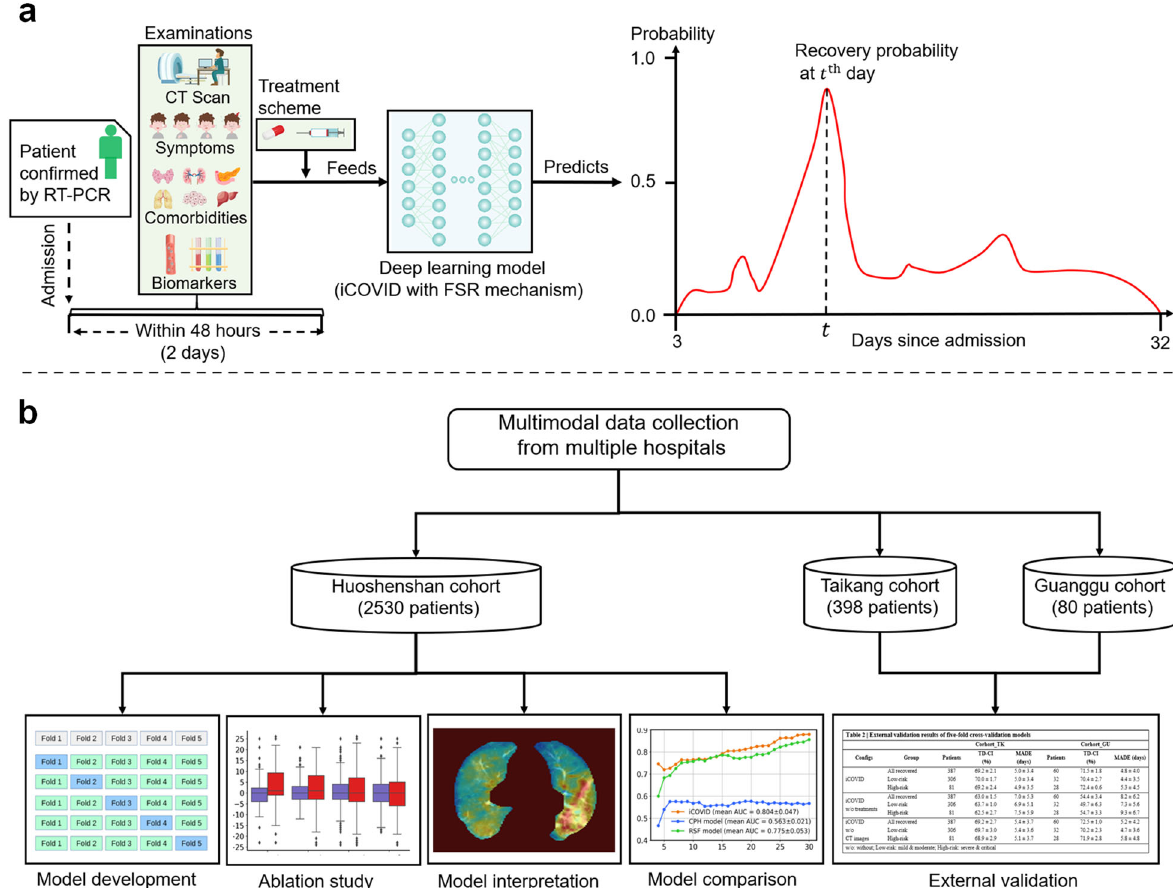
Fig. 1 Prognostic model development and study design for recovery-time prediction. a Multimodal clinical data of a patient (i.e., CT images, symptoms, comorbidities, and biomarkers acquired within 48 hours after admission) are fed into a deep learning model to predict recovery probabilities in a time range. b Development and validation of the deep learning model based on multicenter